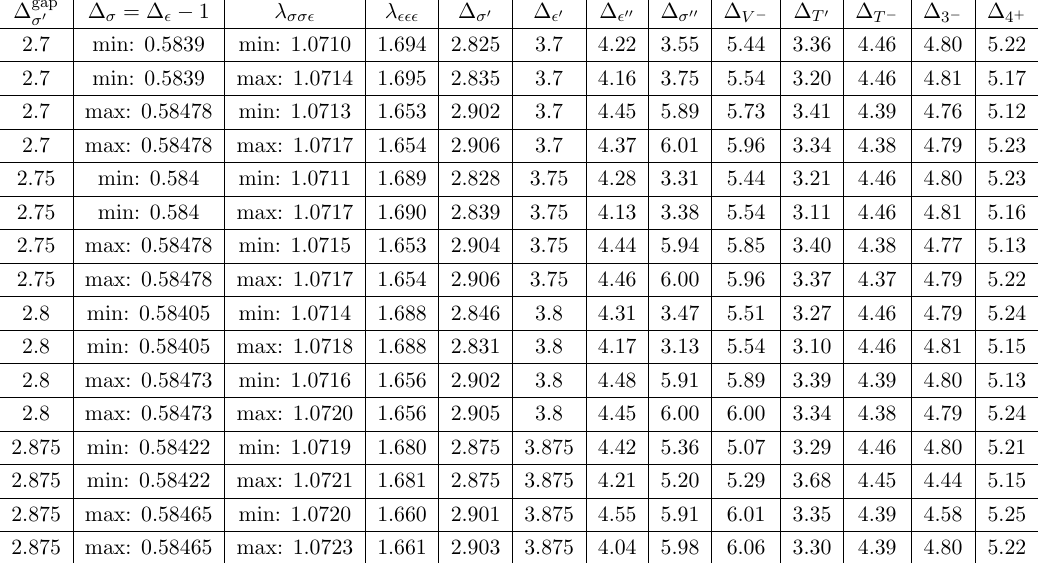
Table 1 . Extracted SUSY Ising CFT Spectra. For each gap (cid:1) gap maximize the leading OPE coe(cid:14)cient (cid:21) (cid:27)(cid:27)(cid:15) at each of the two intersections of the curves in (cid:12)gure 6 with the SUSY constraint given by equation (3.1), corresponding to the minimum and maximum allowed values of (cid:1) (cid:27)